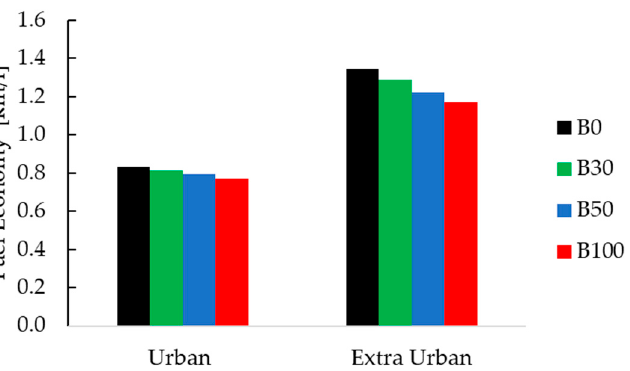
Figure 8. Fuel Economy using modified carbon balance equation for B0, B30, B50 and B100.